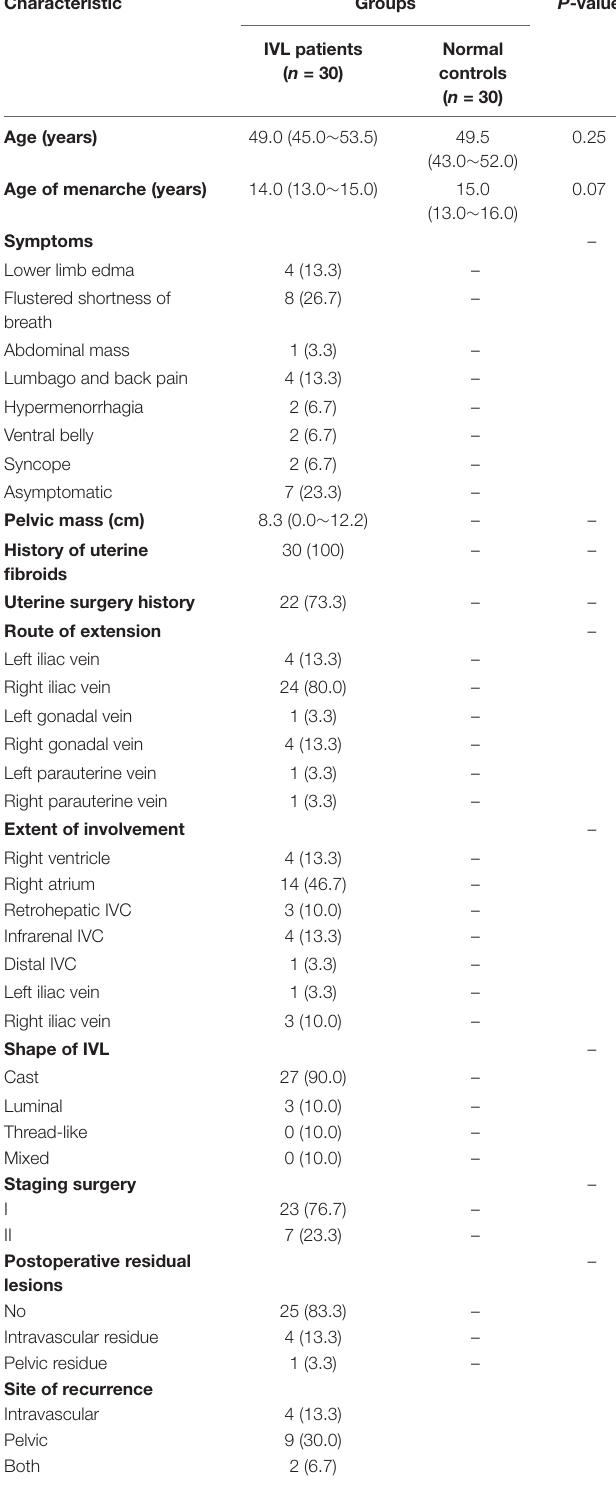
TABLE 1 | Baseline characteristics of the involved